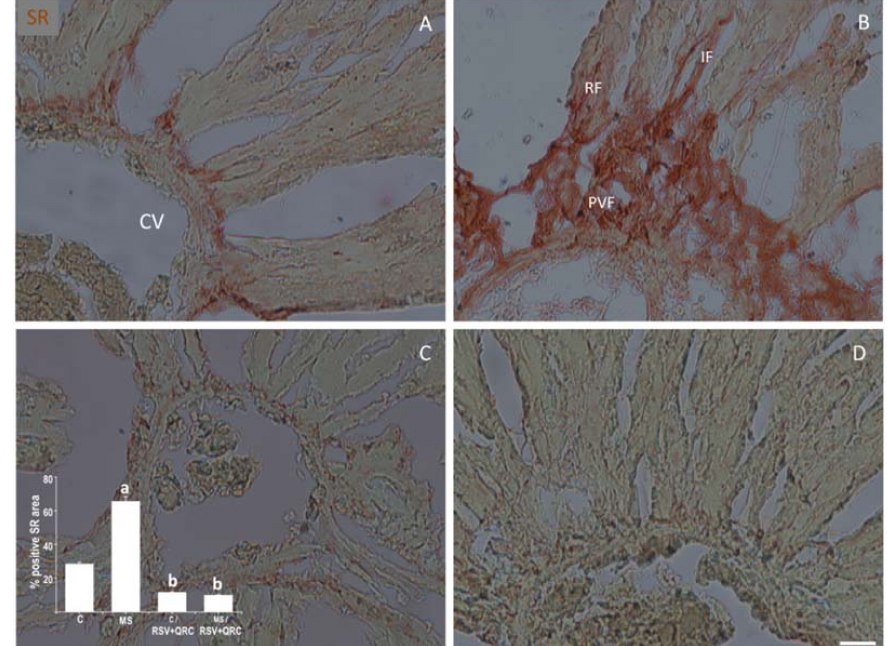
Figure 5. Effect of the administration of Resveratrol and Quercetin on fibrosis by Picrus-Sirius Red staining (SR) in livers from Control and MS rats. Representative images of the central vein (CV) of each condition are presented. Hepatocytes (RF) surrounding the vessels. The graph with the % SR positive (fibrosis) area in each group is shown in the lower-left corner. a p < 0.05 vs. Control: b p < 0.01 vs. MS group. Panel ( A ) = Control group, Panel ( B ) = metabolic syndrome (MS) group, Panel ( C ) = Control/RSV + QRC group, Panel ( D ) = MS/RSV + QRC group. Abbreviations: PVF = perivascular fibrosis; IF = interstitial fibrosis, RF = replacement fibrosis (hepatocytes surrounding the vessels). Bar = 50 µ m.